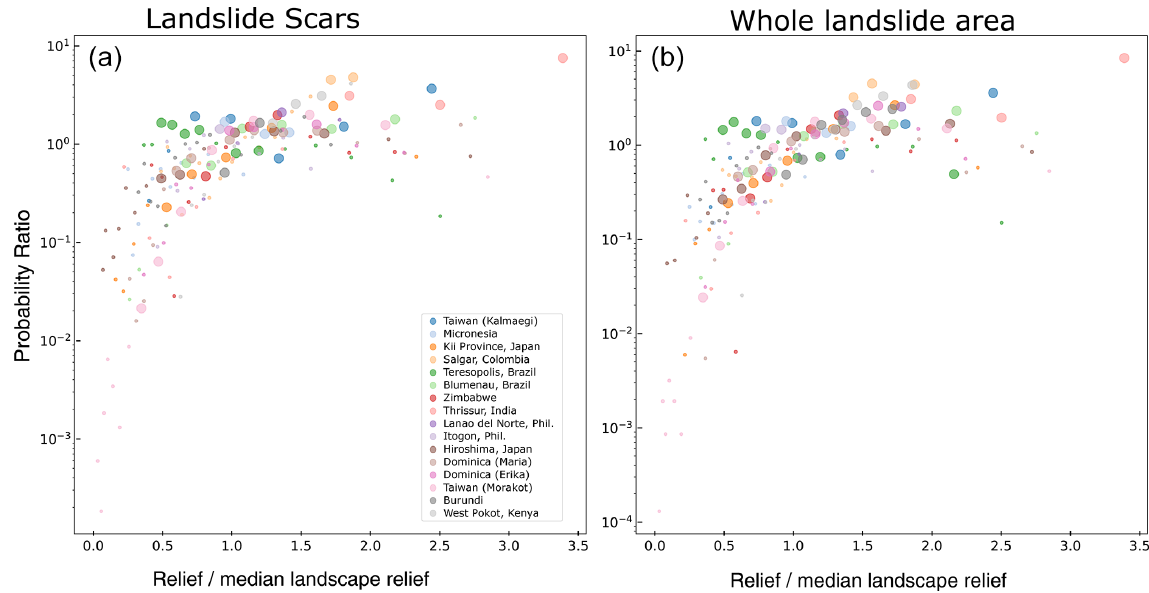
Figure 8. Same as Fig. 4 but for relief in a 1km radius of each cell.